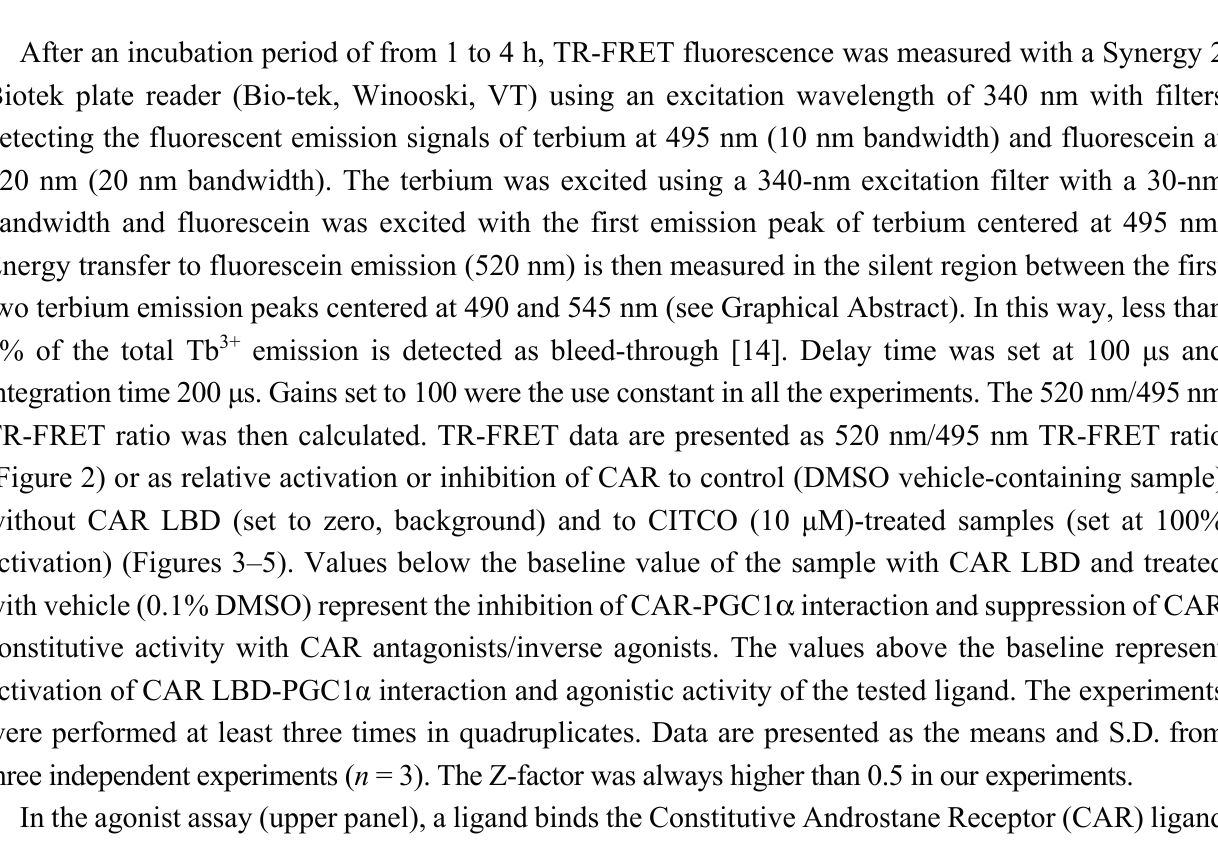
Figure 1. Principle of the TR-FRET (Time-Resolved Fluorescence Resonance Energy Transfer) LanthaSceen TM CAR Coactivator